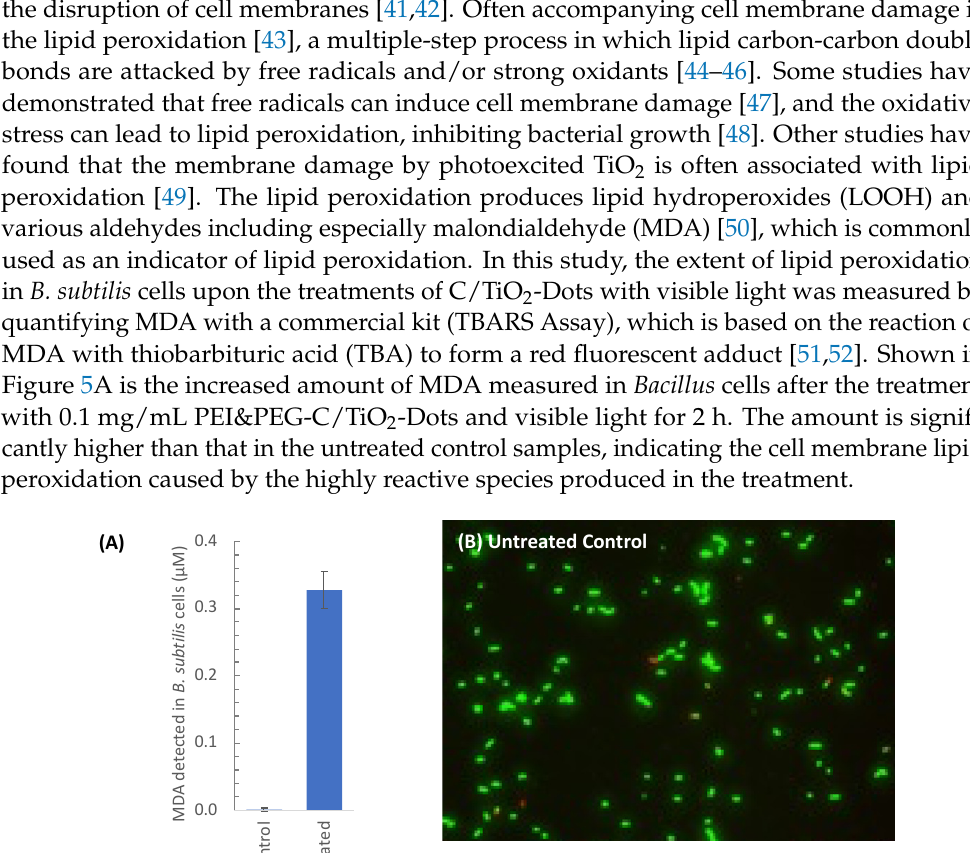
Figure 5. ( A ) The increased amount of MDA in B. subtilis cells after they were treated with PEI&PEG- C/TiO 2 -Dots at 0.1 mg/mL with visible light for 2 h. ( B – D ) The fluorescent images of B. subtilis cells without dots treatment, with 0.02 mg/mL, and 0.1 mg/mL PEG&PEI-C/TiO 2 -Dots treatment with visible light for 2 h, respectively, and stained with live/dead bacterial viability kit. The damage to the cell membrane can be assessed more directly with the live/dead bacterial viability kit, which contains two nucleic acid dyes, SYTO 9 and propidium iodide (PI), to stain the live and dead cells for their significant differences in the membrane permeability. The green SYTO 9 dye can penetrate membranes of both live and dead cells, but the red PI dye can only penetrate the damaged cell membranes of dead cells. Thus, the kit stains the live cells with intact membranes in green, and the dead cells with damaged membranes in red. Figure 5B–D illustrates the changes in cell permeability due to the treatment with PEG&PEI-C/TiO 2 -Dots and visible light. In control samples, almost all cells were viable and stained green (Figure 5B), but in the treated cells there was obvious damage to the cell membrane, more evident when higher dot concentrations were